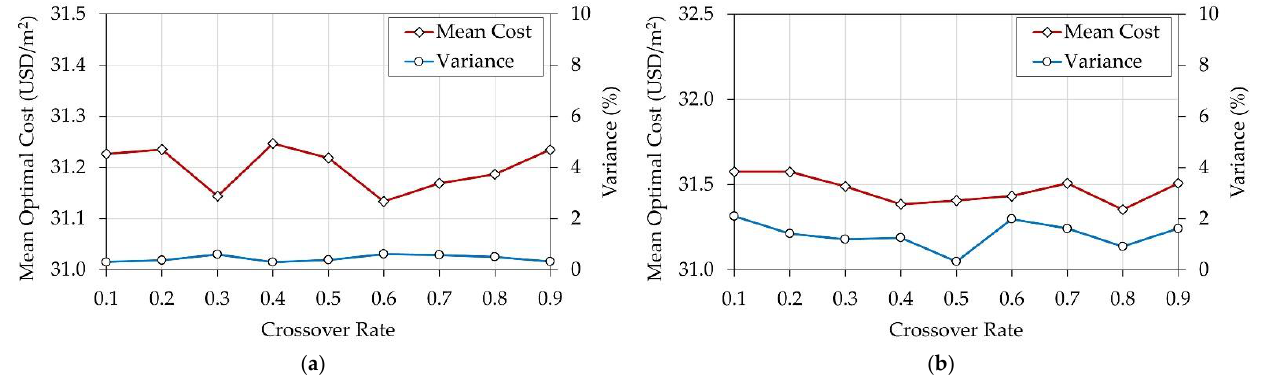
Figure 10. Effects of crossover rate on mean optimal cost: ( a ) FSWD; ( b ) FS.